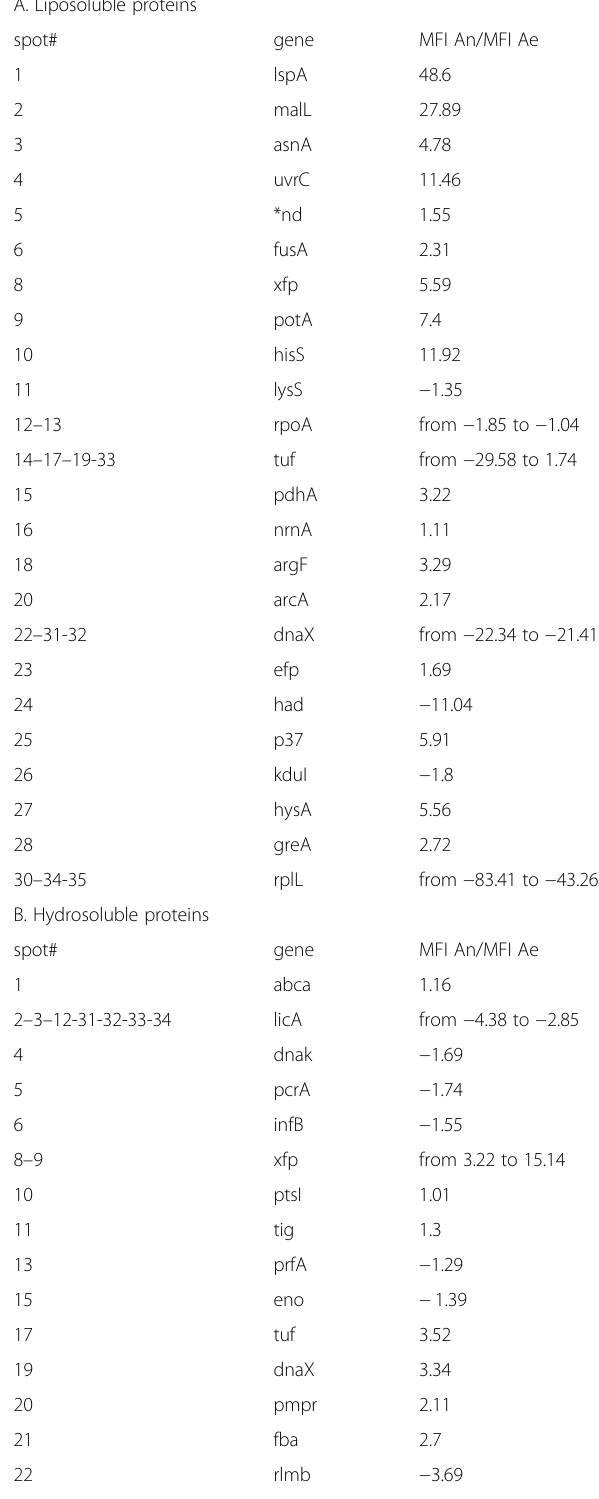
Table 3 Protein ratio of liposoluble (A) and hydrosoluble (B) fraction of Mycoplasma fermentans. The ratio MFI anaerobic versus MFI aerobic is shown